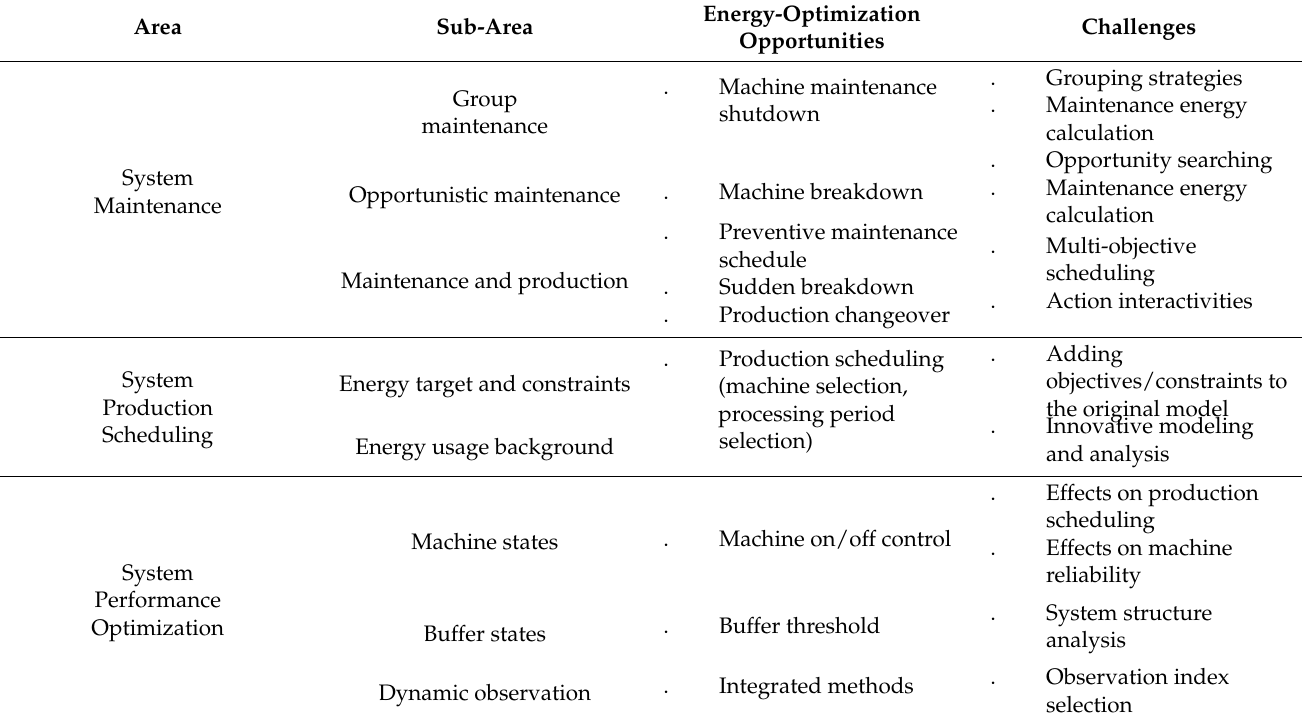
Table 2. Energy-optimization opportunities and challenges in O&M at production-line